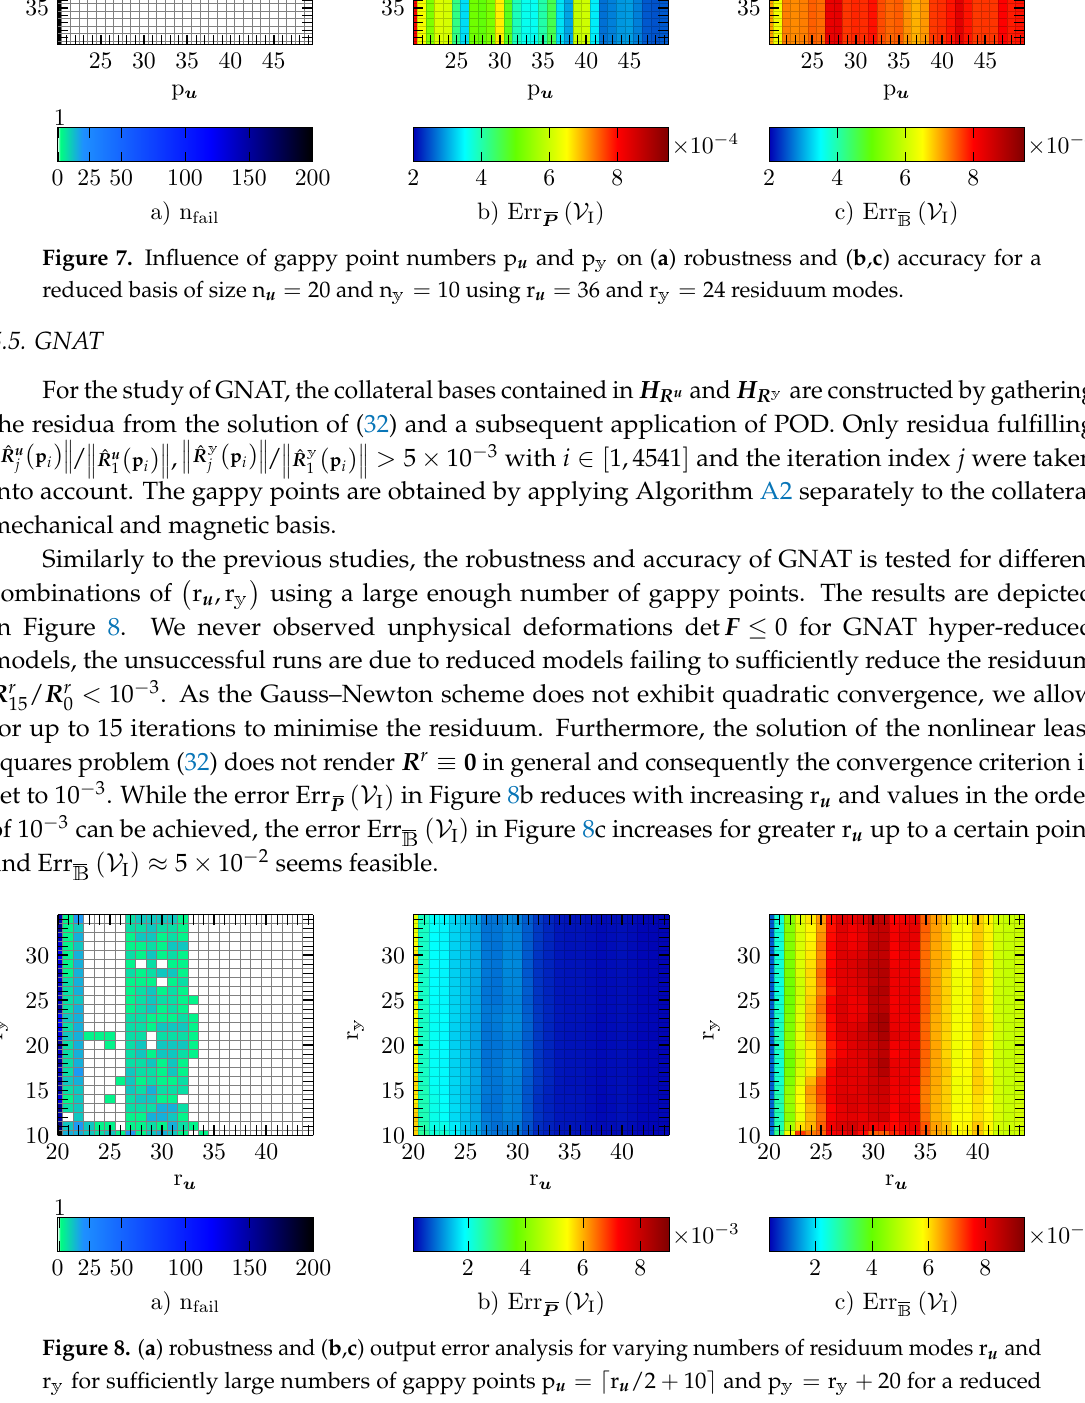
r u /2 + 10 and p y = r y + 20 for a reduced (cid:100) (cid:101)